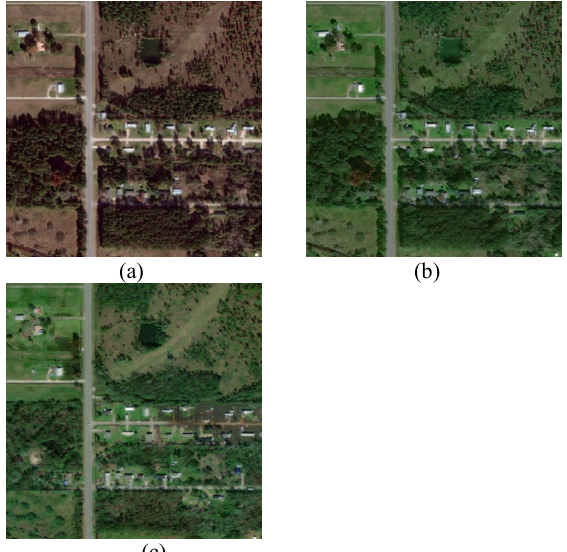
Figure 5 . Example graph of the results of image style transfer by CycleGAN. (a) pre-disaster image before transfer(Real); (b) pre-disaster image transferred to post-disaster style (Fake); (c) post-disaster image of the same region (Real)